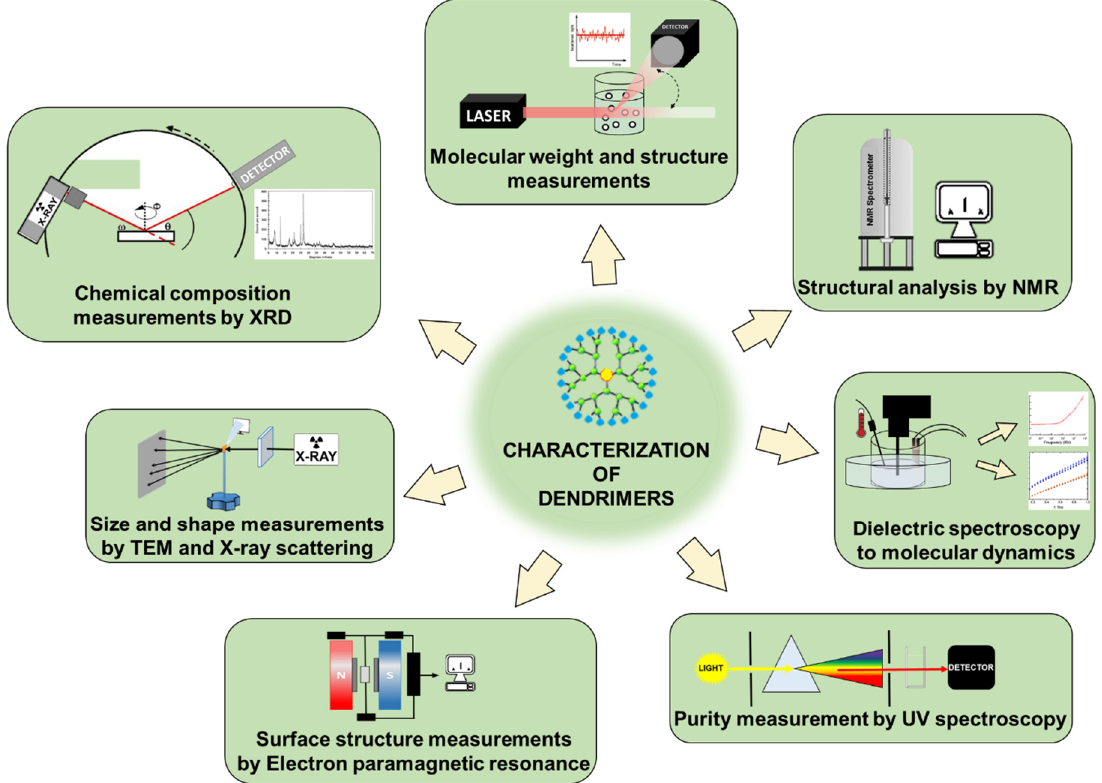
Figure 5. Various analytical techniques for the characterization of dendrimers.